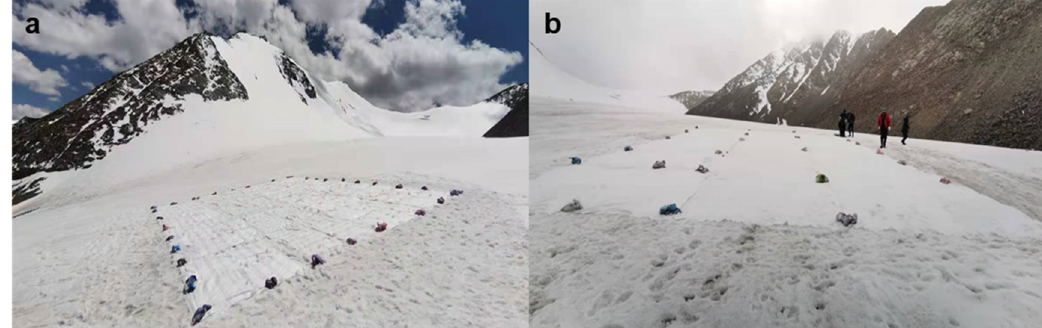
Figure 2. Covered nanofiber material ( a ) and geotextile ( b ) on 24 June 2021.